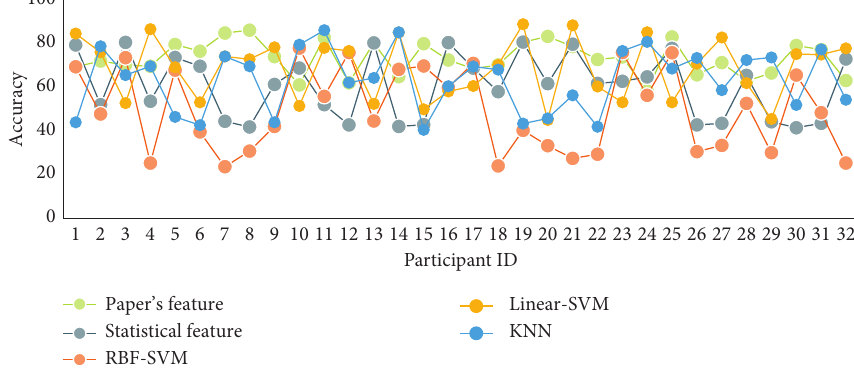
Figure 5: Comparison of accuracy of two-category emotion recognition of five algorithms. Table 5: The influence of different emotional states on brain nerves.